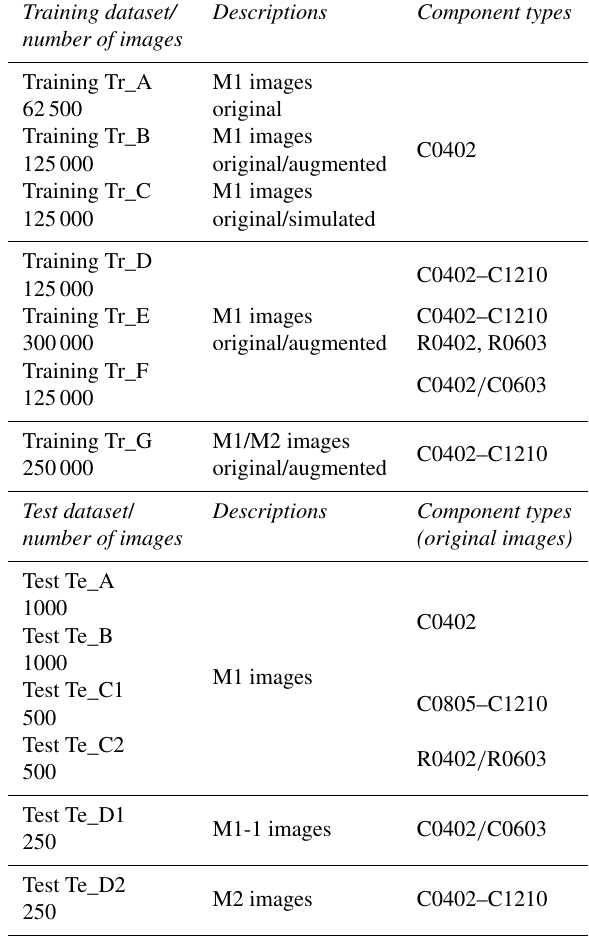
Table 3. Overview of used datasets.